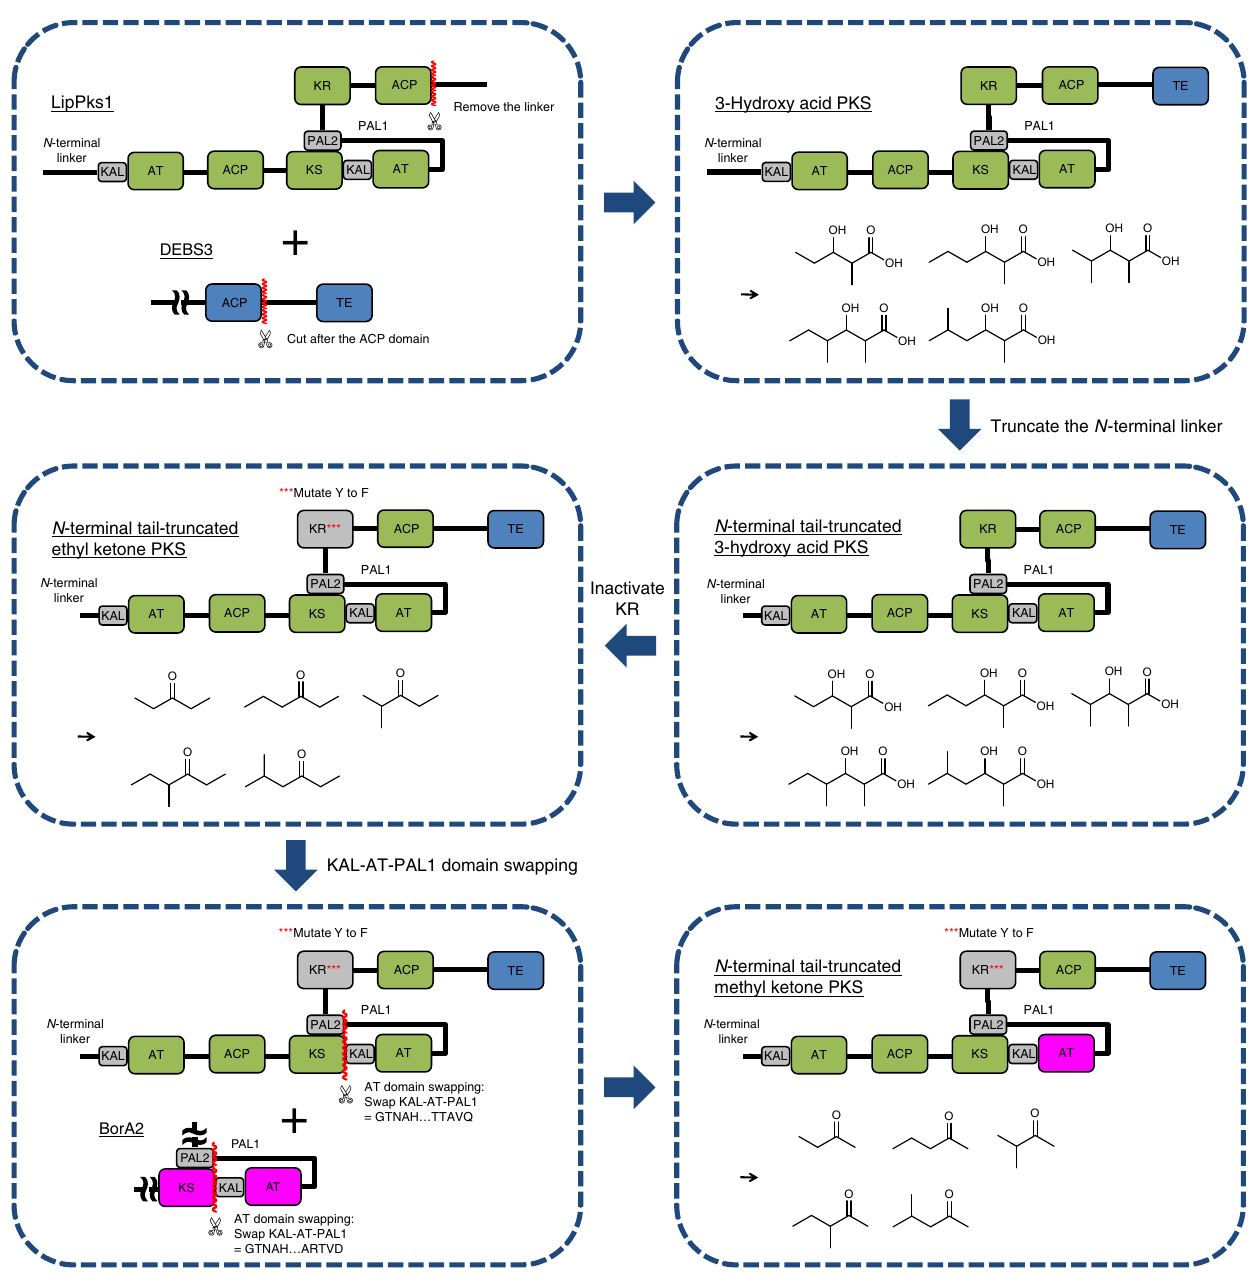
Fig. 1 Hybrid polyketide synthases engineered to produce short-chain ketones. Short-chain ketone-producing polyketide synthases (PKSs) were created by engineering of LipPks1, a type I modular PKS. Catalytic domains of LipPks1 are shown in green. The non-catalytic domains are shown in gray. Linkers are shown as black line. The TE domain (blue) is derived from the erythromycin PKS. The AT domain shown in magenta is derived from the borrelidin PKS module 1, which is speci fi c for malonyl-CoA. Enzymatic products that can be produced by each PKS were shown in the same box. AT acyltransferase, ACP acyl carrier protein, CoA coenzyme A, KAL KS to AT linker, KR ketoreductase, KS ketosynthetas, PAL Post AT linker, TE (Supplementary Fig. 3 and Supplementary Table 5). Each fl ask produced expected 2-methyl-3-pentanone and 4-methyl-3-hex- was fi tted with a silicon sponge closure, which permits exchange anone, which has never been produced biologically. Among them, of gasses but reduces evaporation of water and short-chain S . albus produced the highest amounts of the ketones (106 ± 6 ketones compared to normal fl ask caps. After culturing for fi ve mg · l − 1 of 2-methyl-3-pentanone and 39 ± 3 mg · l − 1 of 4- days at 30 °C, the culture broth was mixed with an equal volume methyl-3-hexanone). We also tested a S . albus strain that of methanol and incubated at 50 °C overnight to fully convert 3- encodes N -terminal tail-truncated ethyl ketone PKS that harbors keto acids produced by PKSs to the corresponding ketones S to A mutation in the KR domain. As expected, the S-to-A (Supplementary Fig. 4). After fi ltration, crude extracts were mutant produced lower amounts of ketones compared to the Y- analyzed by liquid chromatography time-of- fl ight mass spectro- to-F mutant (Supplementary Fig. 1b). For methyl ketones metry (LC-TOF-MS). As shown in Fig. 2a, all of the strains (Fig. 2b), S . albus was the only strain that produced expected 3- transformed with the gene encoding the ethyl ketone PKS methyl-2-butanone (18 ± 6 mg · l − 1 ) and 3-methyl-2-pentanone